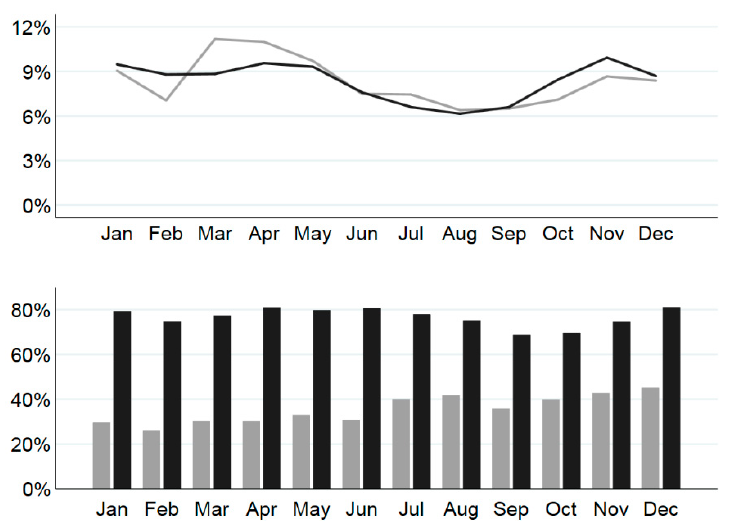
Figure 1. Percentages of the year’s admissions to RSPCA Queensland shelters for 13,911 cat admissions in 2011 (upper graph; grey line) and 13,220 admissions in 2016 (black line) by calendar month of admission and, in lower graph, percentages rehomed by day 90 after admission for admissions in which the cat was available to be rehomed for 12,372 admissions in 2011 (grey bars) and 10,954 admissions in 2016 (black bars).